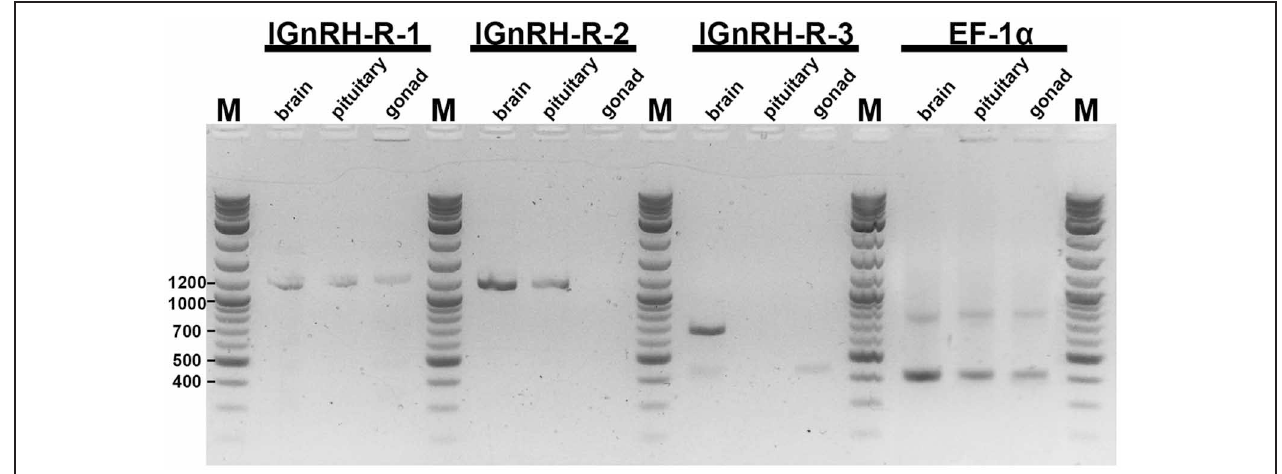
FIGURE 1 | Electrophoresis of RT-PCR products on a 1.8% TAE agarose gel. The expected band size for each of the receptor RNA is as follows: lGnRH-R-1 at 1229bp; lGnRH-R-2 at 1153bp; and lGnRH-R-3 at 655bp. EF-1 α